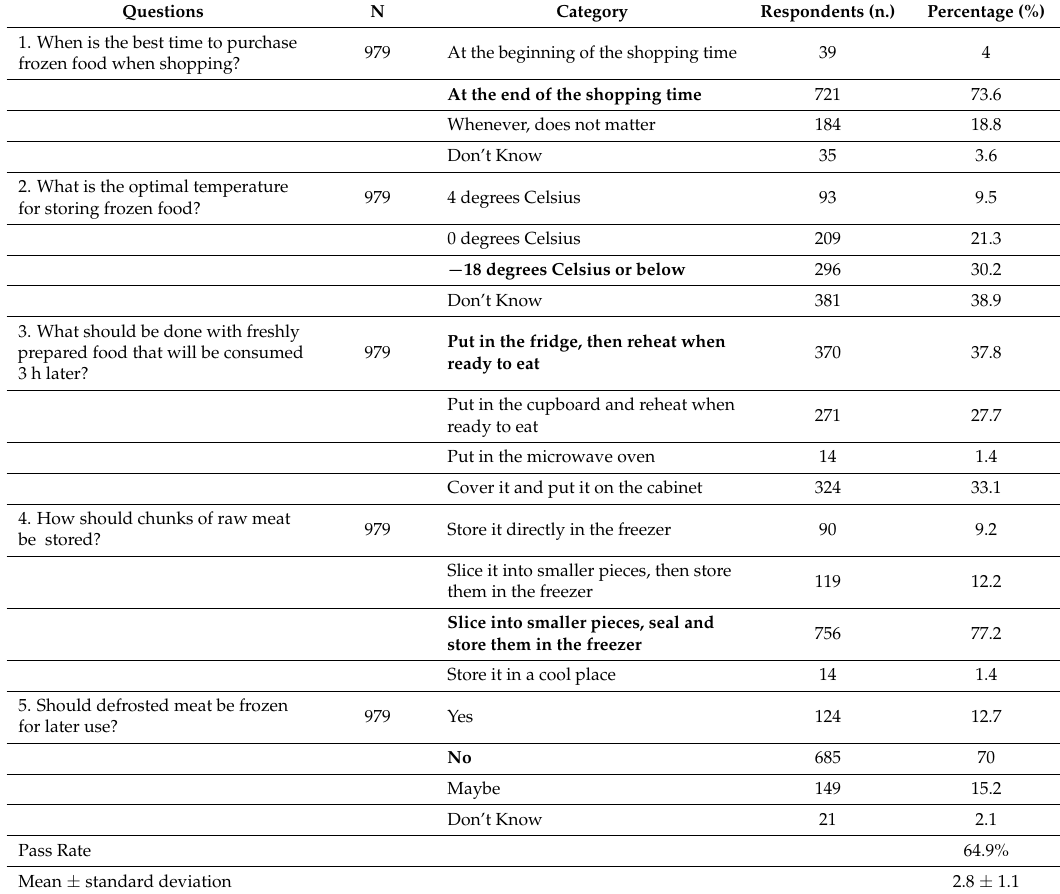
Table 2. Respondents’ knowledge on food storage, pass rate, mean score and standard